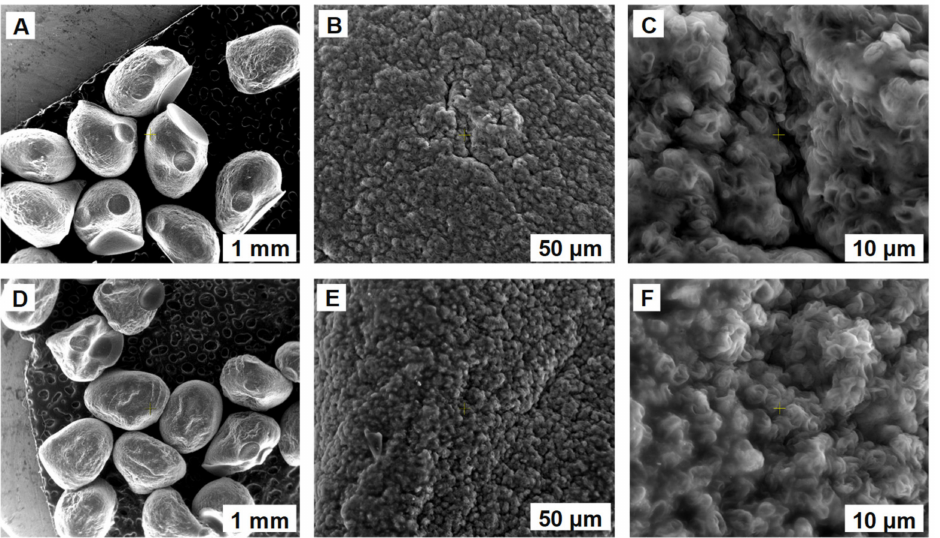
Figure 2. SEM images of SPA 5% biosorbent prepared before ( A – C ) and after ( D – F ) biosorption of ethacridine lactate from aqueous